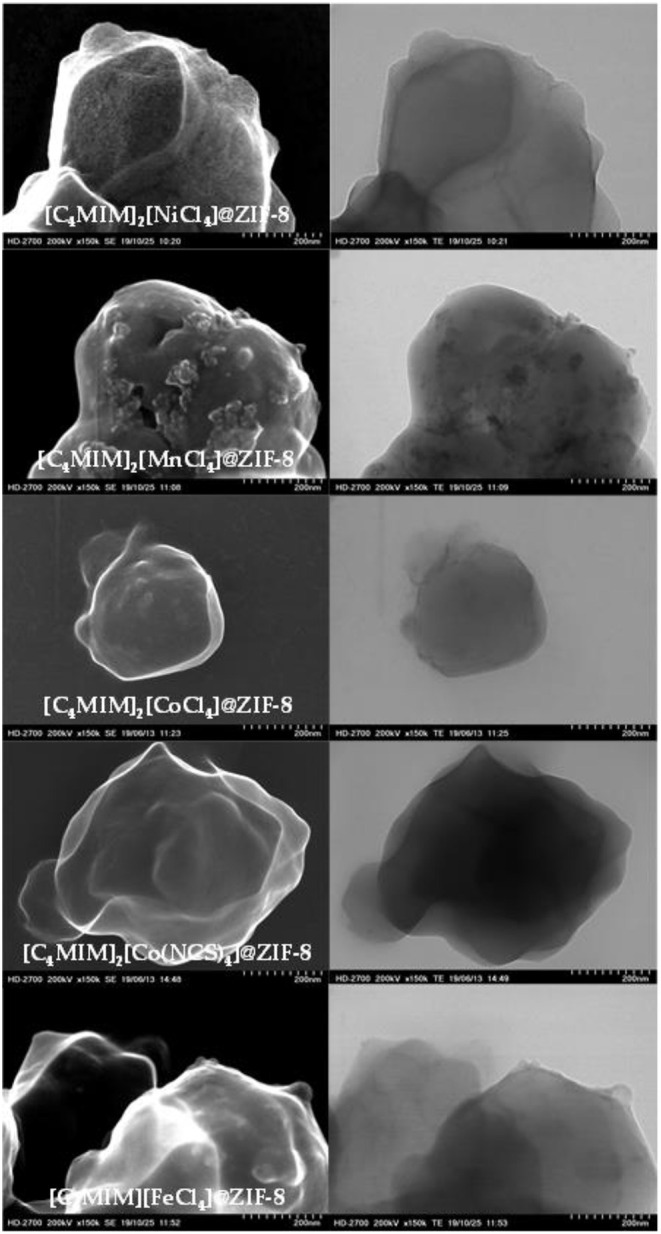
SEM (left) and TEM (right) imaging of magIL@ZIF-8 composites (150k x magnification and 200 nm scale).